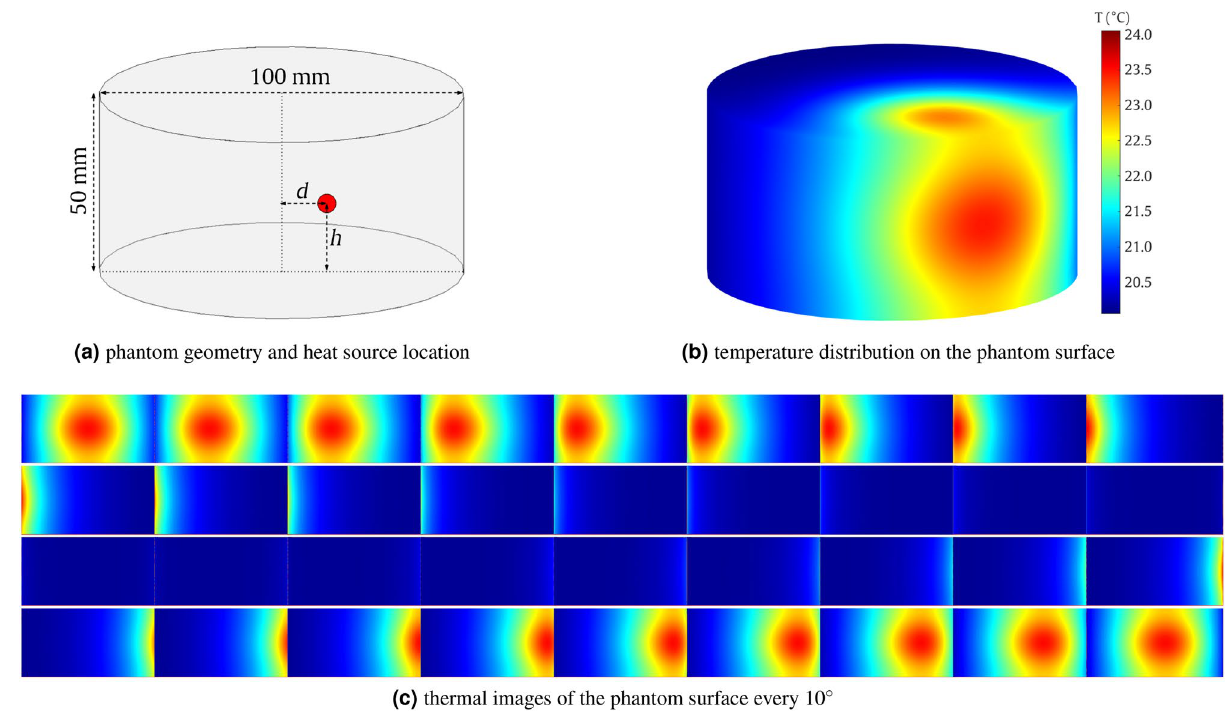
Figure 1. Illustration of the synthetic dataset generation from a cylindrical phantom.